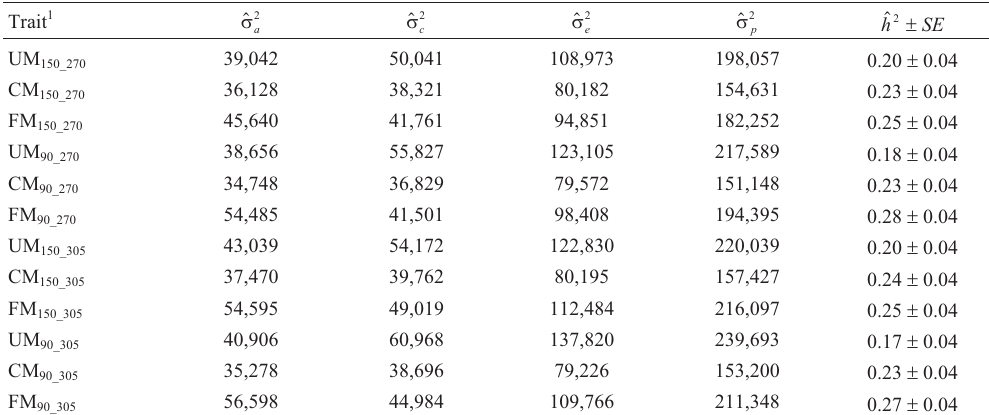
Table 2 - Estimates of additive genetic variance ( (cid:2) (cid:5) (cid:2) heritability ( h 2 ) obtained by one-trait